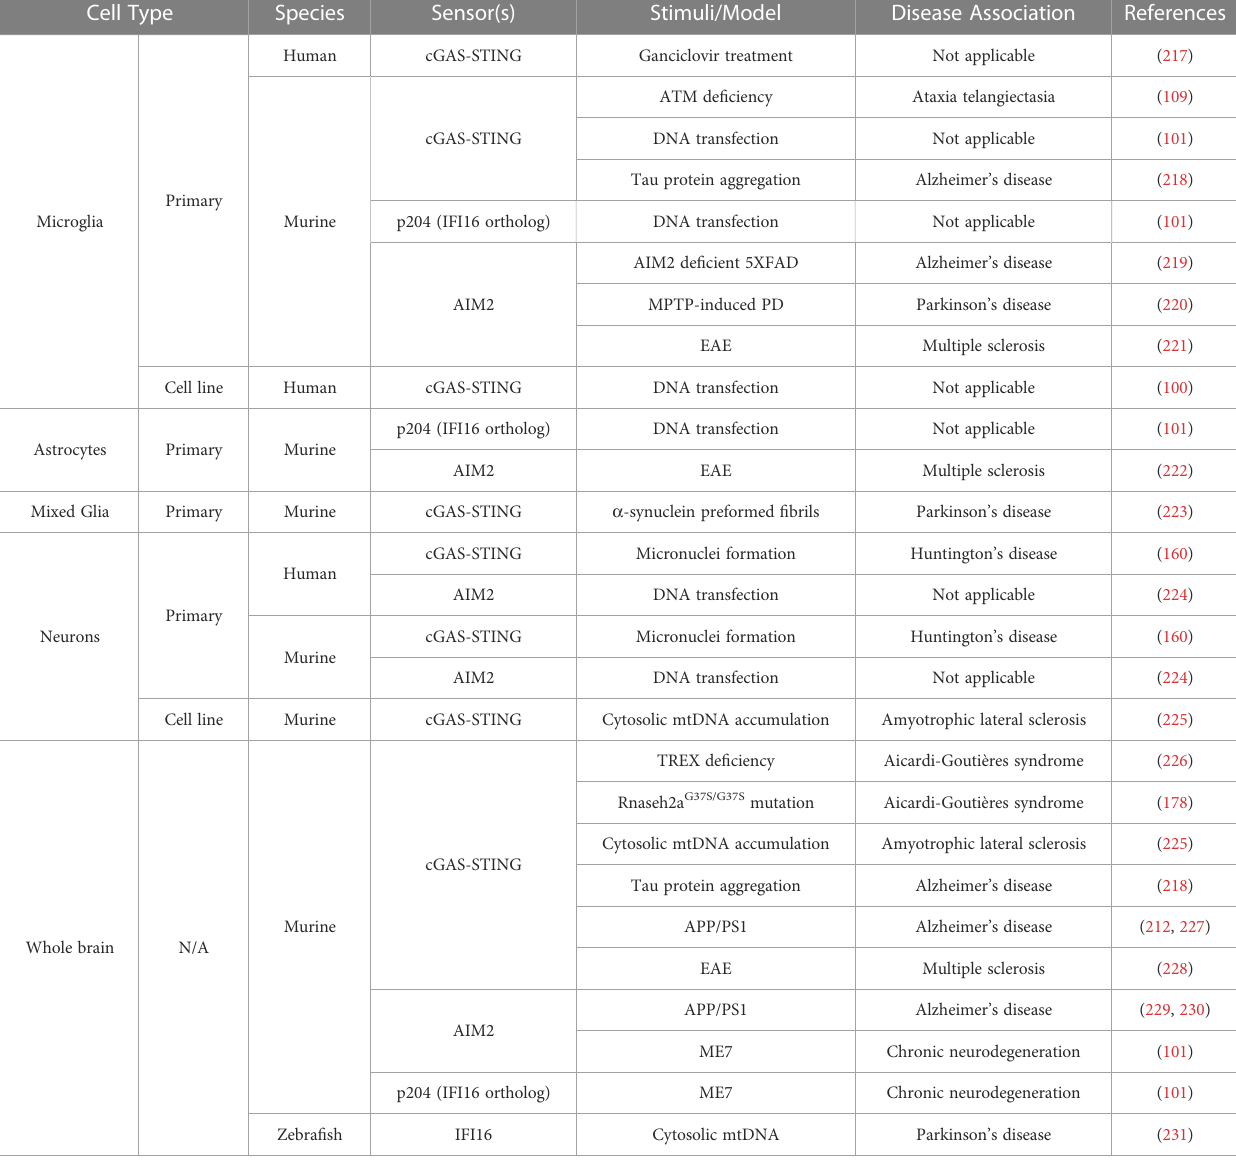
TABLE 1 Expression of DNA sensors by CNS cells and links to neurogenerative